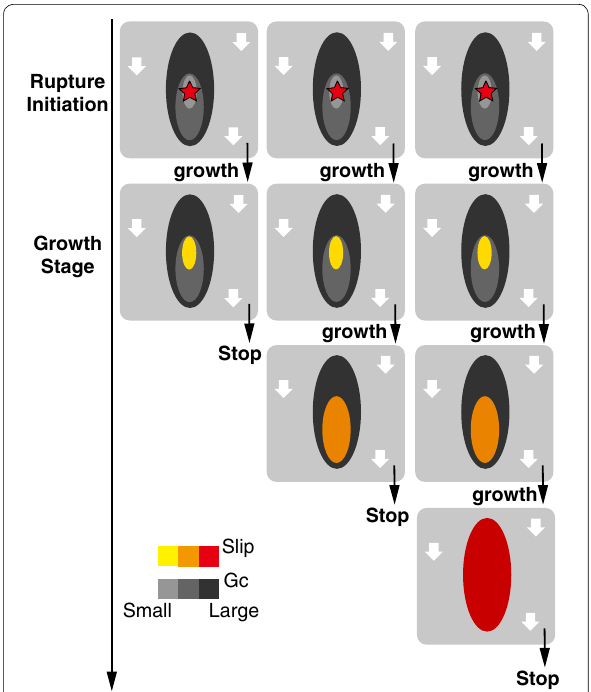
Fig. 10 Conceptual hierarchical patch model. The hierarchical structure, which is defined by the different patch sizes in the figure, controls the overall earthquake behavior. A large earthquake can be interpreted as the result of a cascade-up process that initiated from a small-patch rupture. The patches are elliptical and elongate in the slip